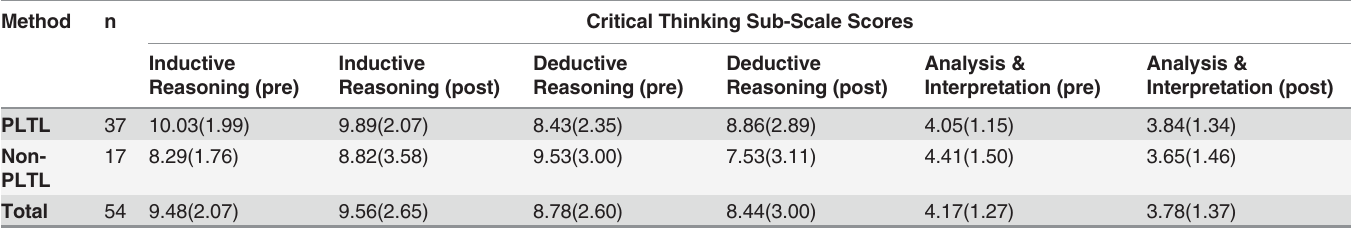
Table 5. In fl uence of Method on Critical Thinking Sub-Scale Scores (Inductive Reasoning, Deductive Reasoning, Analysis & Interpretation).